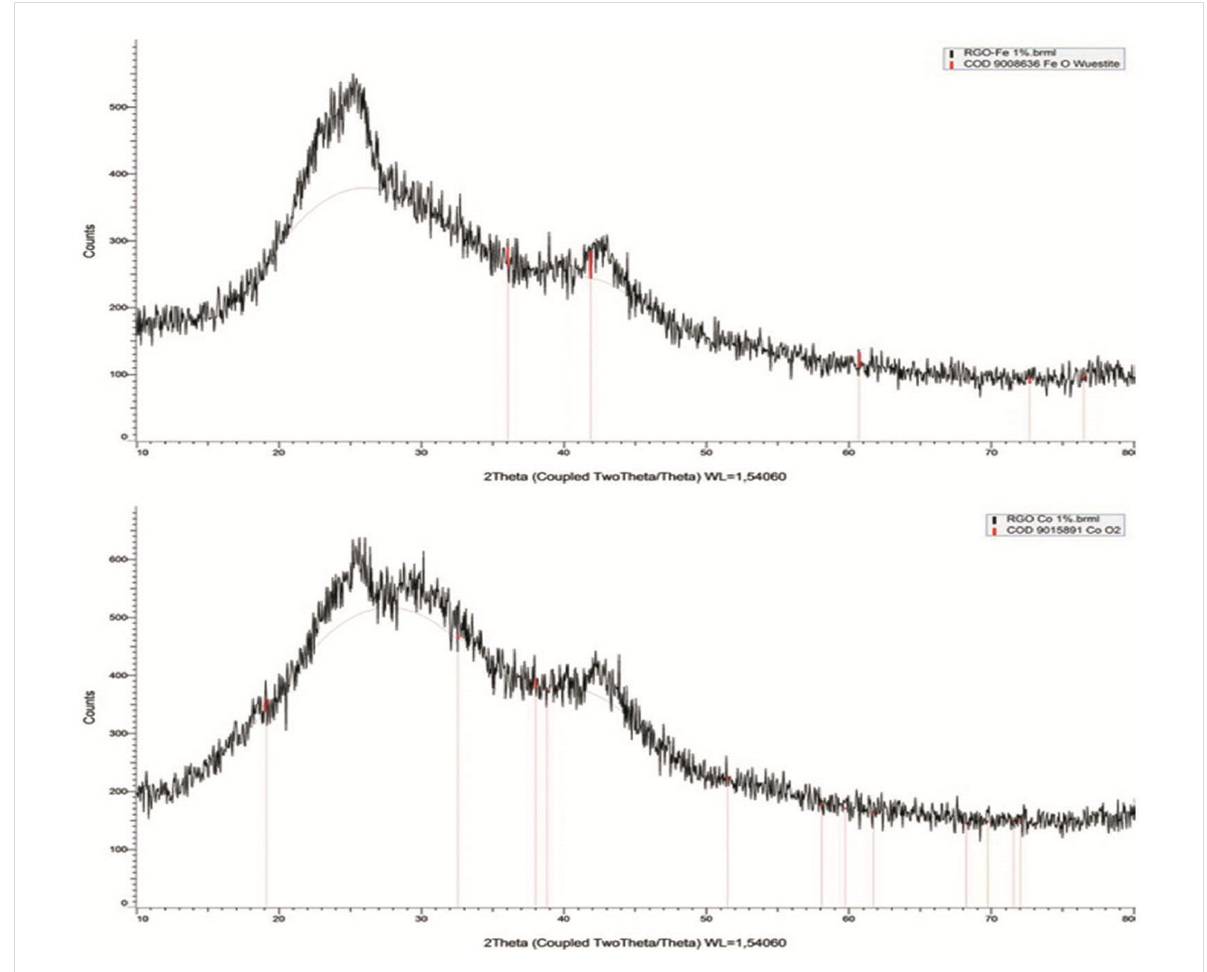
Figure 4: Powder XRD patterns of RGO supported Fe and Co NPs.